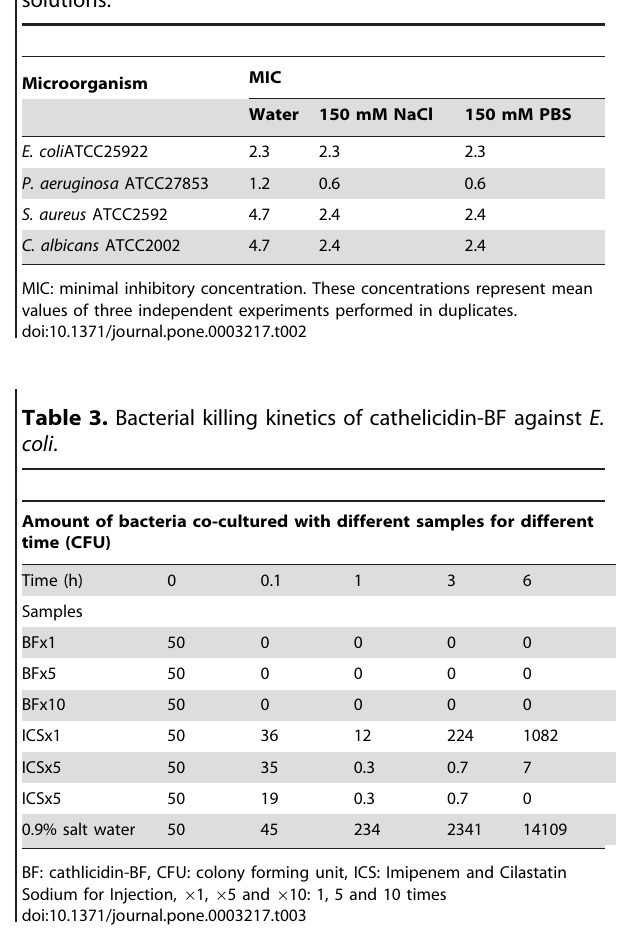
Table 2. Antimicrobial activity of cathelicidin BF in different solutions.